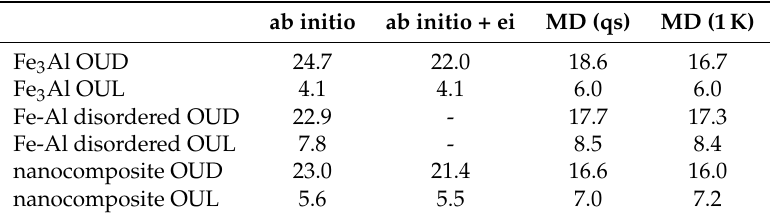
Table 1. The tensile strengths σ ts in the [001] direction for the Fe 3 Al compound and the disordered Fe-Al phase with 18.75 at.% Al together with their nanocomposite from ab initio calculations, from quasi-static simulations and from the molecular dynamics simulations at temperature of 1K. The table contains the tensile strengths obtained from maximum at stress-strain dependence (ab initio; except of the value of 24.7 GPa for Fe 3 Al OUD, which corresponds rather to a structural transformation), the ab initio tensile strength obtained from elastic instability (ab initio + ei), molecular static (MD (qs)) and molecular dynamics at the temperature of 1K. ab initio ab initio +